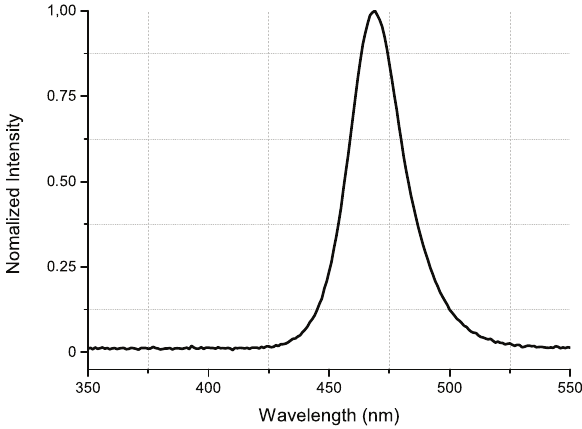
Figure 6. Experimental LED’s normalized light intensity as a function of the wavelength. LED peak intensity is at approximately 470